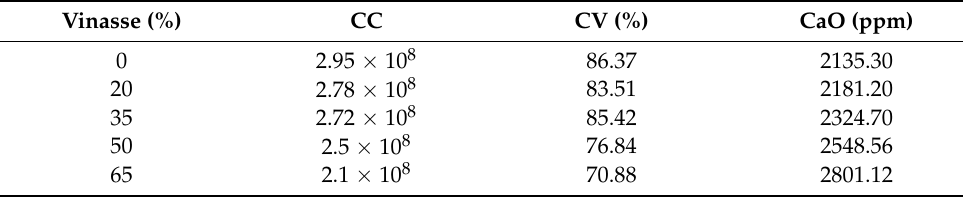
Table 2. Effect of vinasse concentration on CC, CV. and CaO